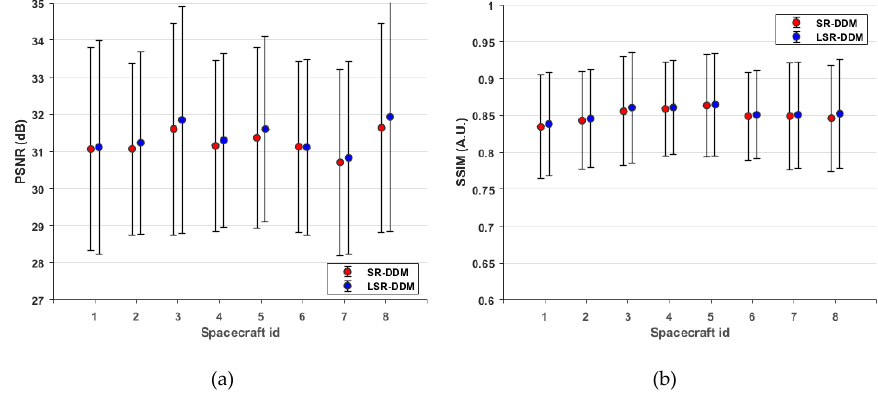
Figure 9. Quality of DDM reconstruction for different satellites. ( a ) Peak signal-to-noise ratio (PSNR) values versus satellite number for SR-DDM and LSR-DDM with one sigma variation. ( b ) Structural similarity index (SSIM) values versus satellite number for SR-DDM and LSR-DDM with one sigma variation.